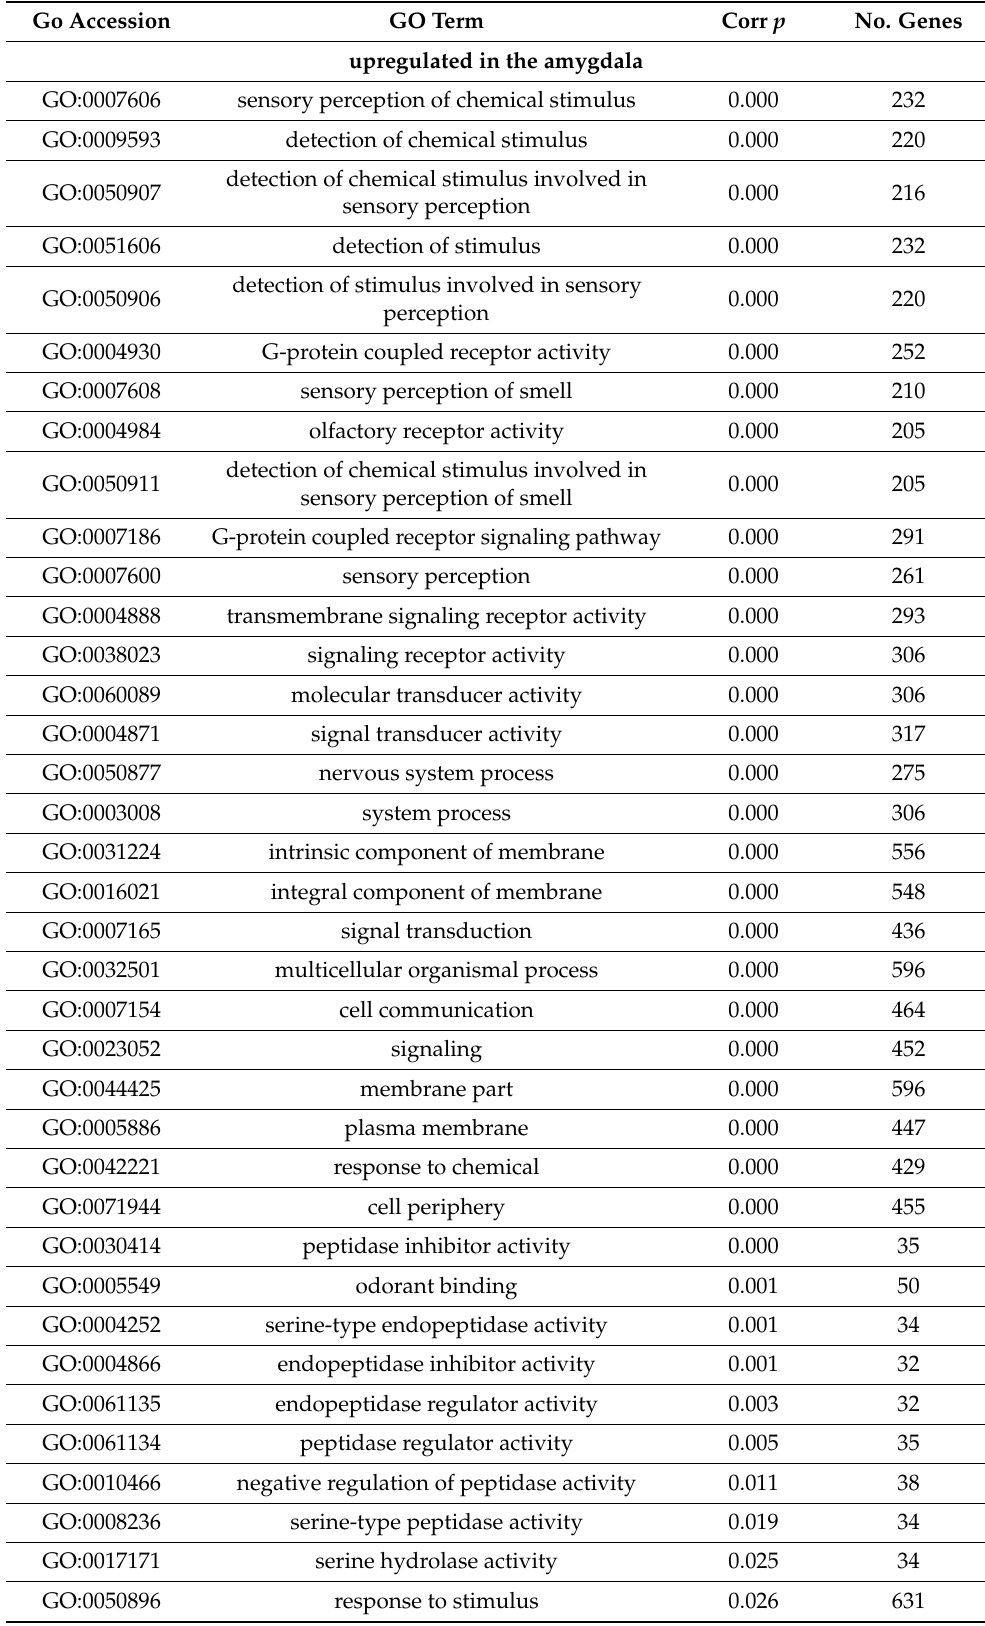
Table 7. Differentially expressed genes enriched in GO terms in amphetamine-exposed rats respond- ing to chronic lithium in comparison to rats before